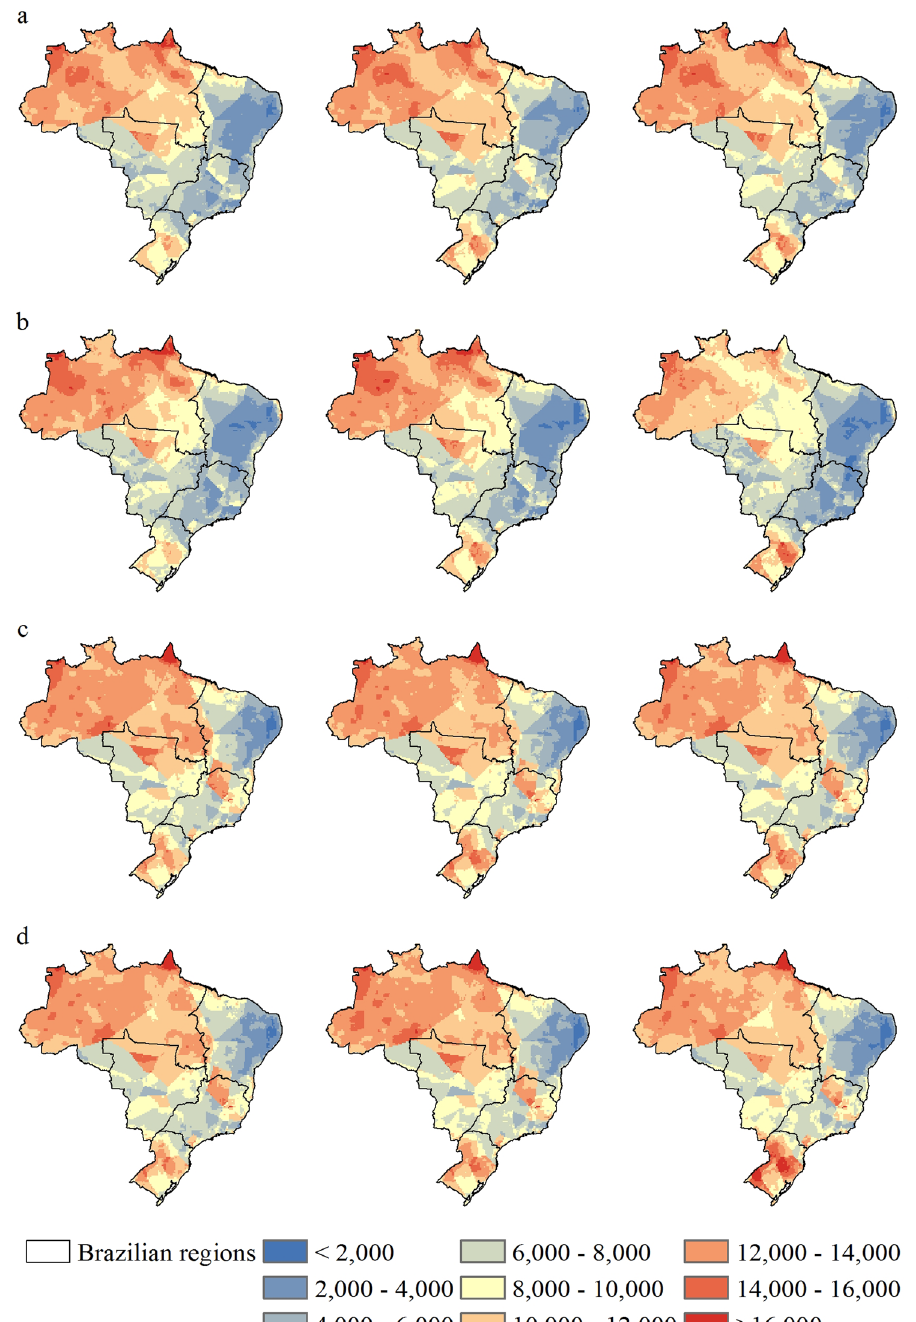
Figure 2. Estimated rainfall erosivity for Brazilian regions through 21 st century. ( a ) RCP4.5 scenario of HadGEM2-ES model for three periods (2007–2040, 2041–2070 and 2071–2099). ( b ) RCP8.5 scenario of HadGEM2-ES model for three periods (2007–2040, 2041–2070 and 2071–2099). ( c ) RCP4.5 scenario of MIROC5 model for three periods (2007–2040, 2041–2070 and 2071–2099). ( d ) RCP8.5 scenario of MIROC5 model for three periods (2007–2040, 2041–2070 and 2071–2099). Values in MJ mm ha − 1 h − 1 year − 1 . Maps created with ESRI ArcGIS 10.1